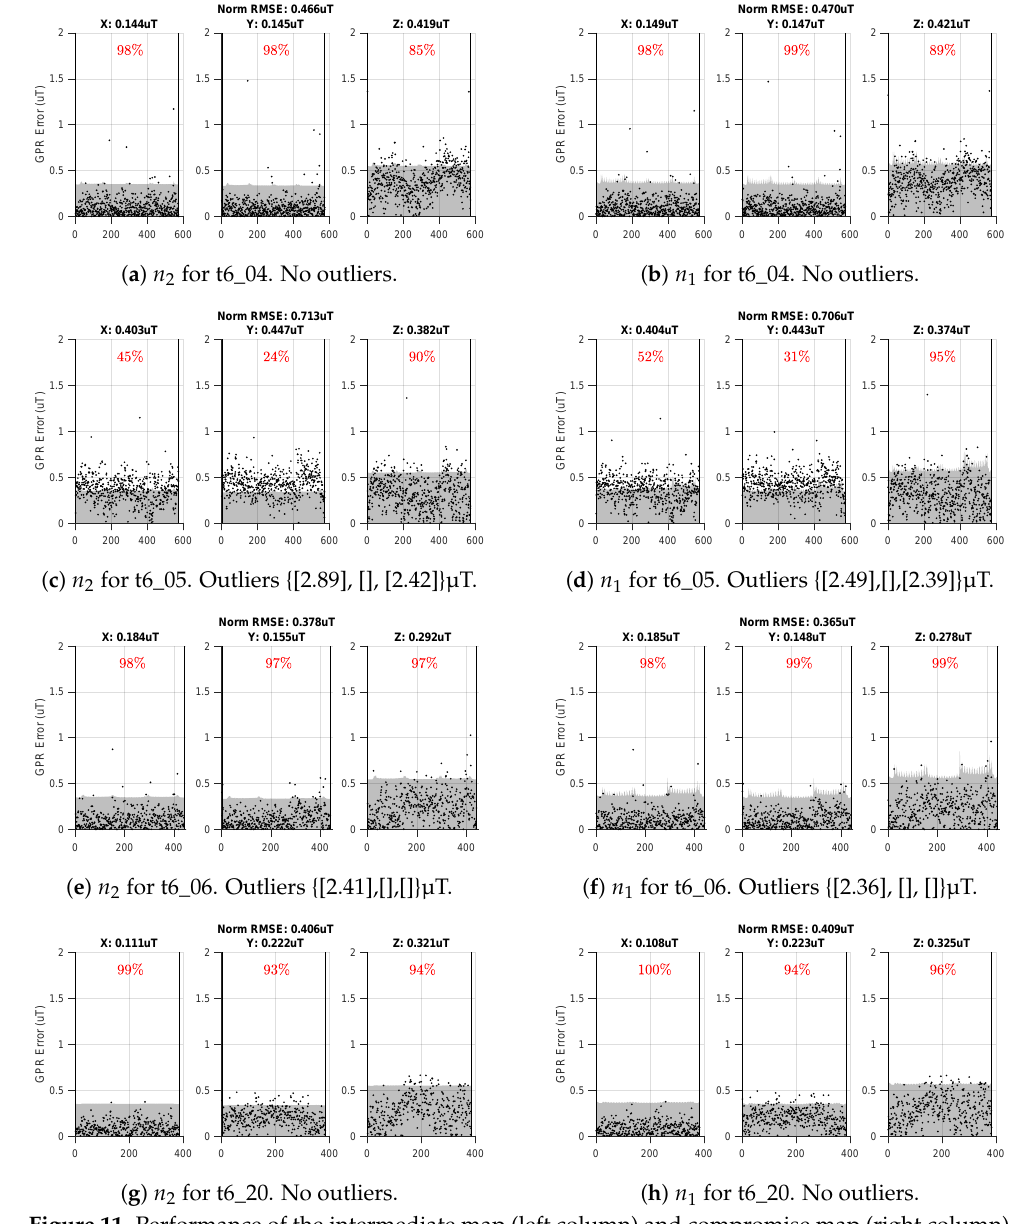
Figure 11. Performance of the intermediate map (left column) and compromise map (right column). Outliers larger than 2 µT are listed for { [ GPR x ], [ GPR y ], [ GPR z ] } in each